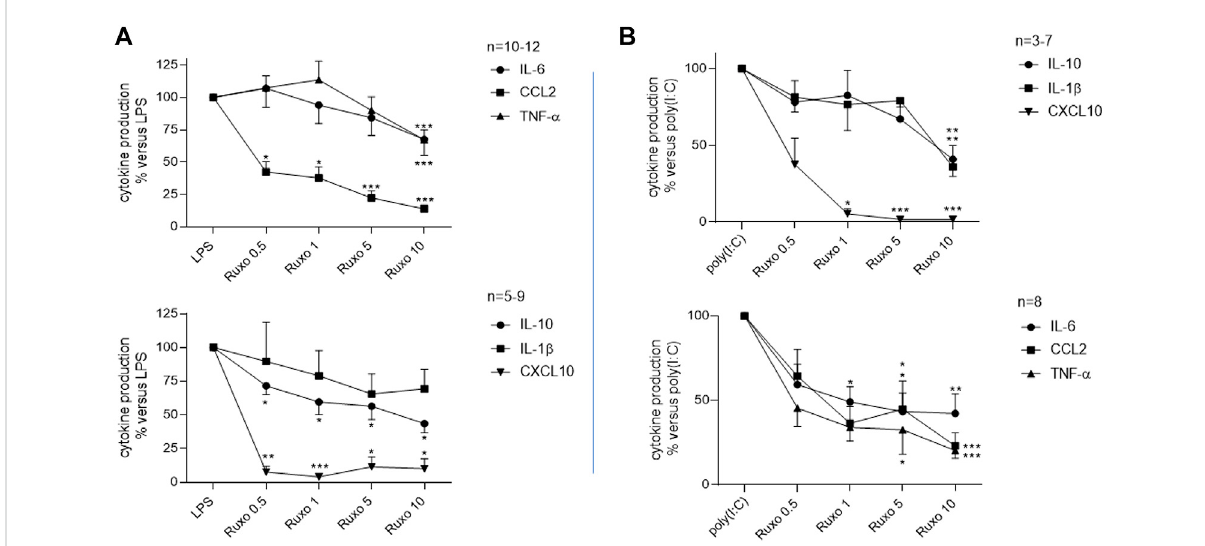
FIGURE 1 Ruxolitinib ’ s inhibitory effect on the LPS or poly (I:C)-induced production of cytokines by LMs. LMs were treated with ruxolitinib (0.5 × 10 – 6 to 10×10 – 6 M)beforestimulationwith (A) :LPS(10 ng · ml − 1 )or (B) :poly(I:C)(10 μ g · ml − 1 )for24 h.DataareexpressedasapercentageofLPSorpoly(I:C)- induced levels of cytokine production. The mean ± SEM results of eight to 12 independent experiments are shown. Asterisks indicate signi fi cant differences with respect to LPS or poly (I:C) (*: < 0.05; **: < 0.01; ***: <